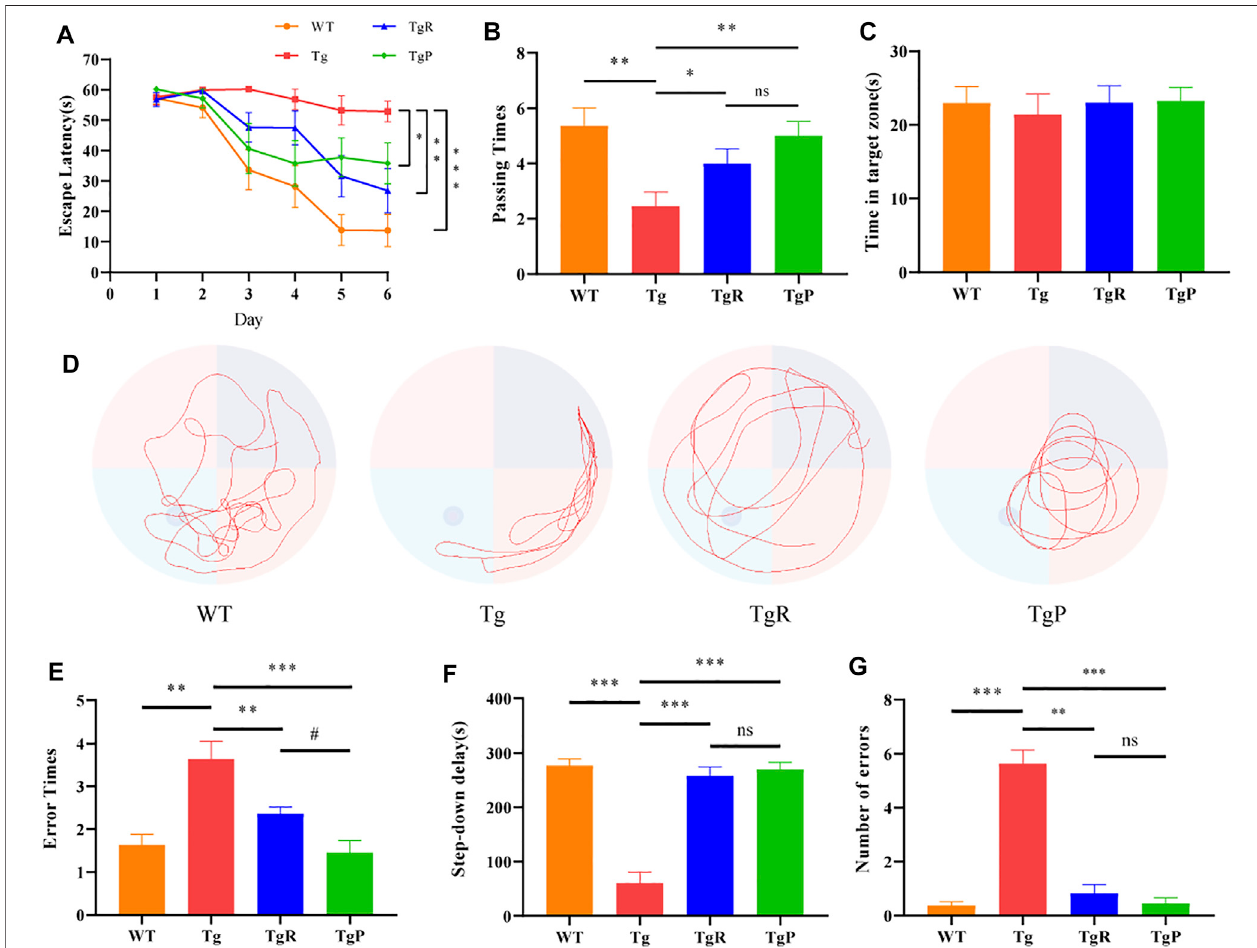
FIGURE 2 | Effects of rhubarb on memory and cognitive function of APP/PS1 mice. (A – D) Morris water maze test, including assessments of escape latency (A) , platform crossing times (B) , swimming time in the target quadrant (C) , representative swimming path (D) . (E – G) Step-down test, including assessments of error times duringtraining (E) ,step-downdelay (F) ,errortimesduringexperiments (G) .Valuesareexpressedasthemean ± S.E.M.; n (cid:1) 9,* p < 0.05versusTg,# p < 0.05versusTgP, by Student ’ s unpaired t -test.